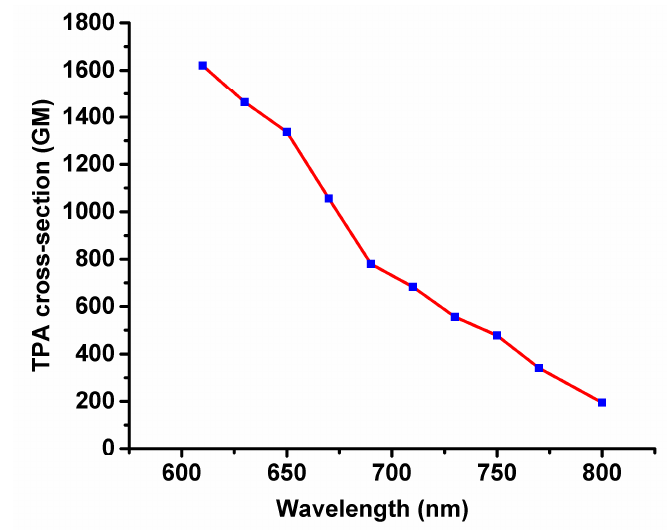
Figure 6. TPA spectra in toluene measured by TPEE method.